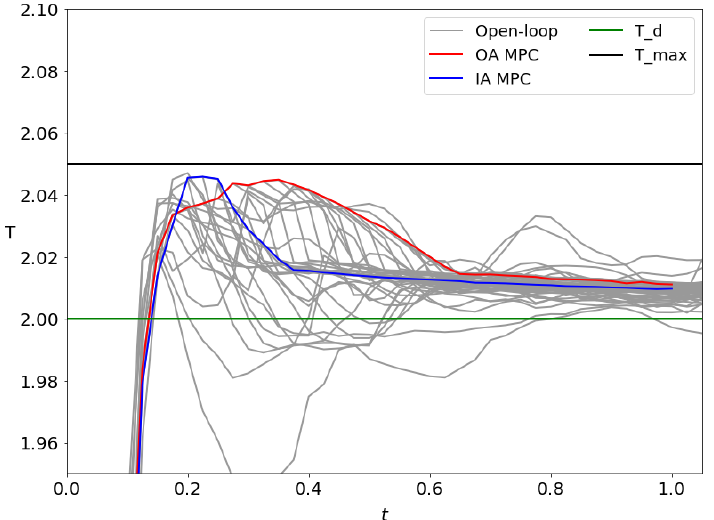
ˆ t + H (cid:48) ] (CCPDEs) 1 , 1